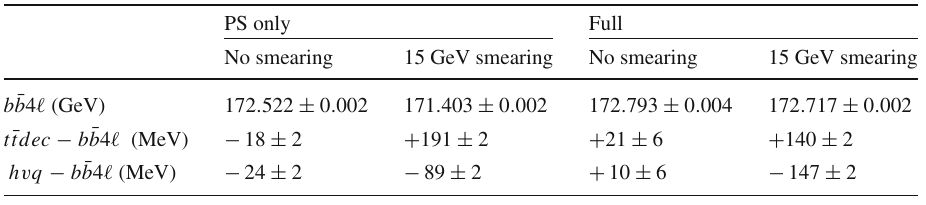
Table 4 m Wb peak position for j m t =172.5 GeV obtained with the three different generators, showered with Pythia8.2 +MEC (default). We also show the differences between Pythia8.2 +MEC and Pythia8.2 without